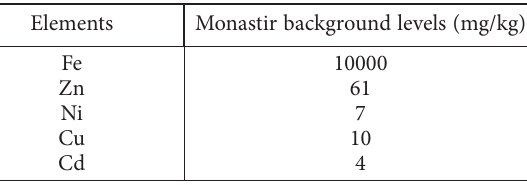
Table 7. Background levels of some heavy metals in Monastir region (mg/kg) (Serbaji, 2000)